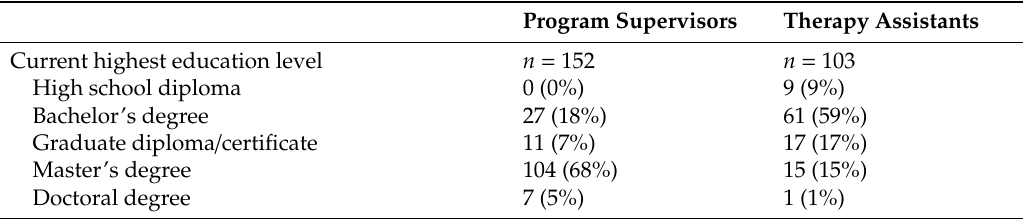
Table 4. Education and credentials of Australian program supervisors and therapy